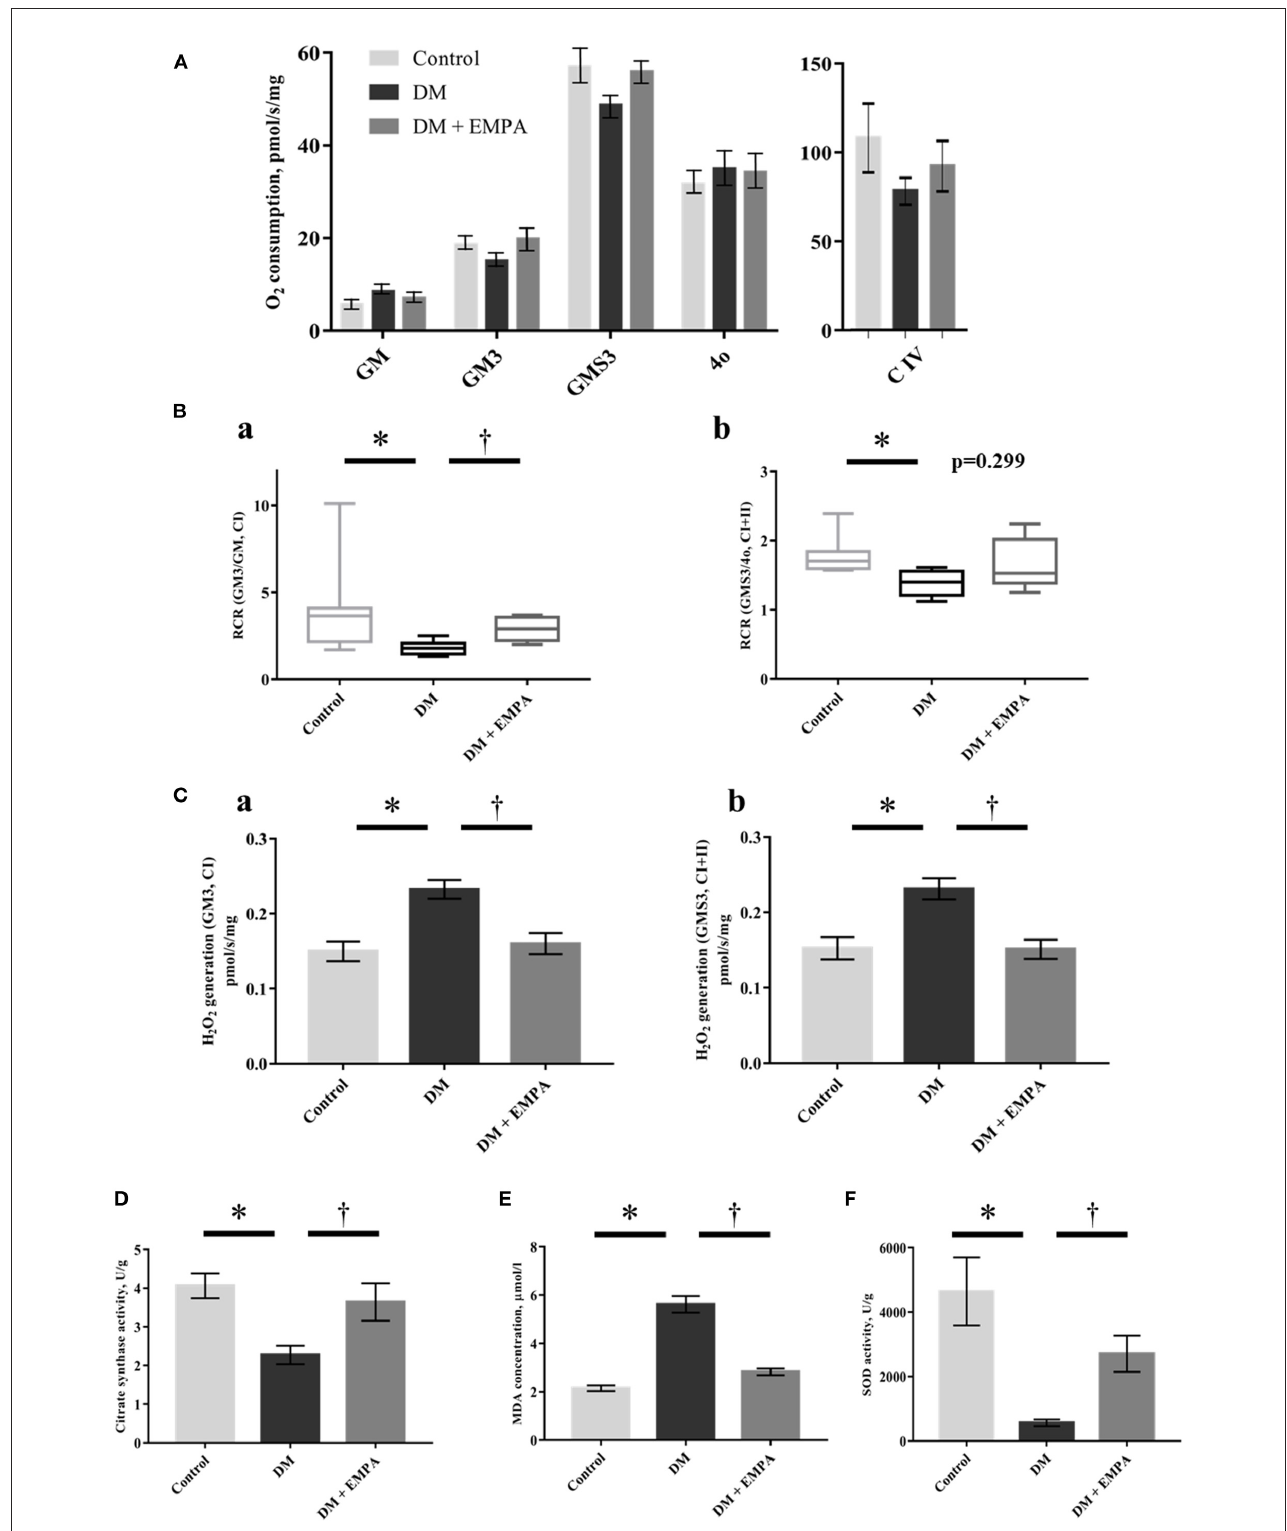
FIGURE4 Effects of empagliflozin on mitochondrial respiratory capacity and ROS generation, as well as oxidative stress in the atrial tissue. (A) Summarized data of mitochondrial respiration during each state ( n = 8 per group). (B) Respiratory control ratio (RCR) with CI-linked substrates (a) and CI + II-linked substrates (b). The line indicates median and error bars indicate the interquartile range ( n = 8 per group). (C) Mitochondrial H 2 O 2 generation with CI-linked substrates (a) and CI + II-linked substrates (b) ( n = 8 per group). (D) Citrate synthase activity ( n = 6 per group). (E) MDA concentration ( n = 8 per group). (F) SOD activity ( n = 6 per group). Data are expressed as mean ± SE or medians (interquartile range), as appropriate. * p < 0.05: vs. Control, † p < 0.05: vs. DM (One-way repeated ANOVA with post hoc Tukey’s multiple-comparison test or Kruskal-Wallis test with post hoc Dunn’s multiple comparison test). GM, state 2 respiration with glutamate + malate; GM3, state 3 respiration with glutamate and malate; GMS3, state 3 respiration with glutamate; malate and succinate; 4o, state 4 respiration with oligomycin; C, complex; H 2 O 2 , hydrogen peroxide; DM, diabetes; EMPA,